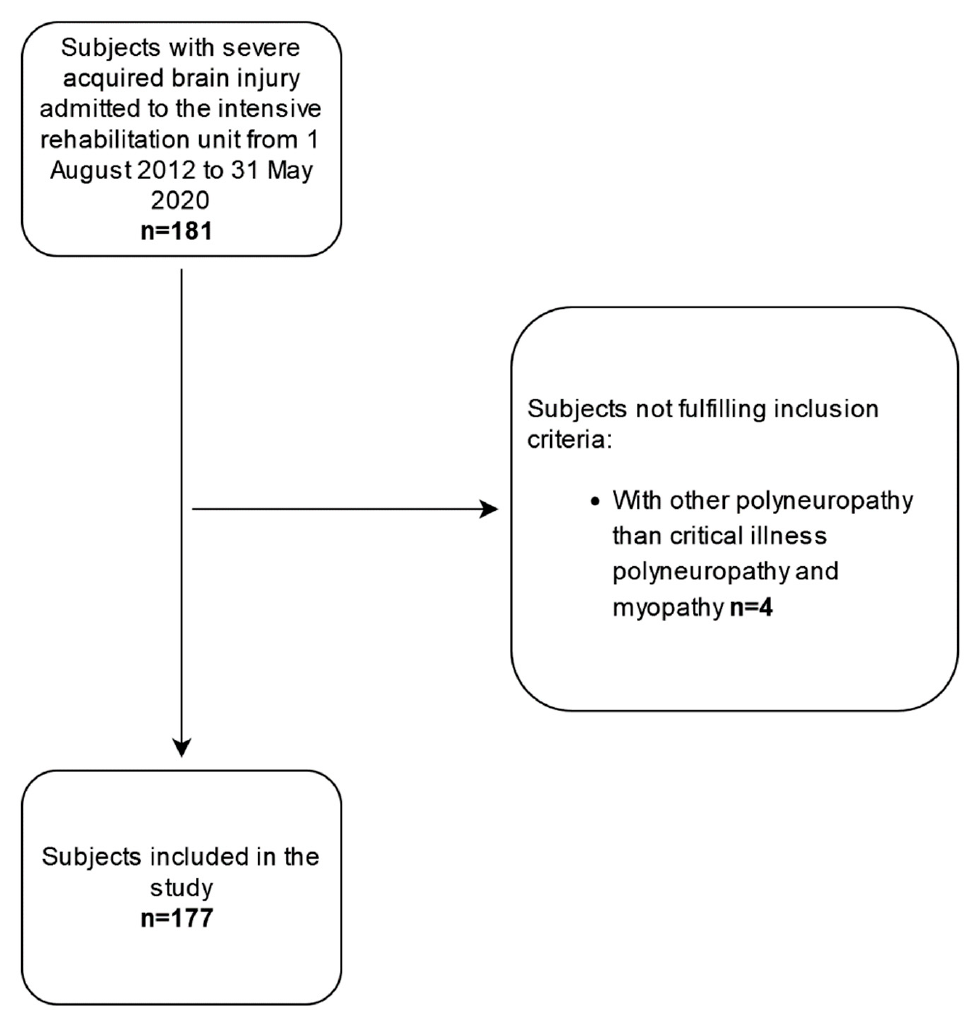
Figure 1. Study Figure 1. Study flow-chart.